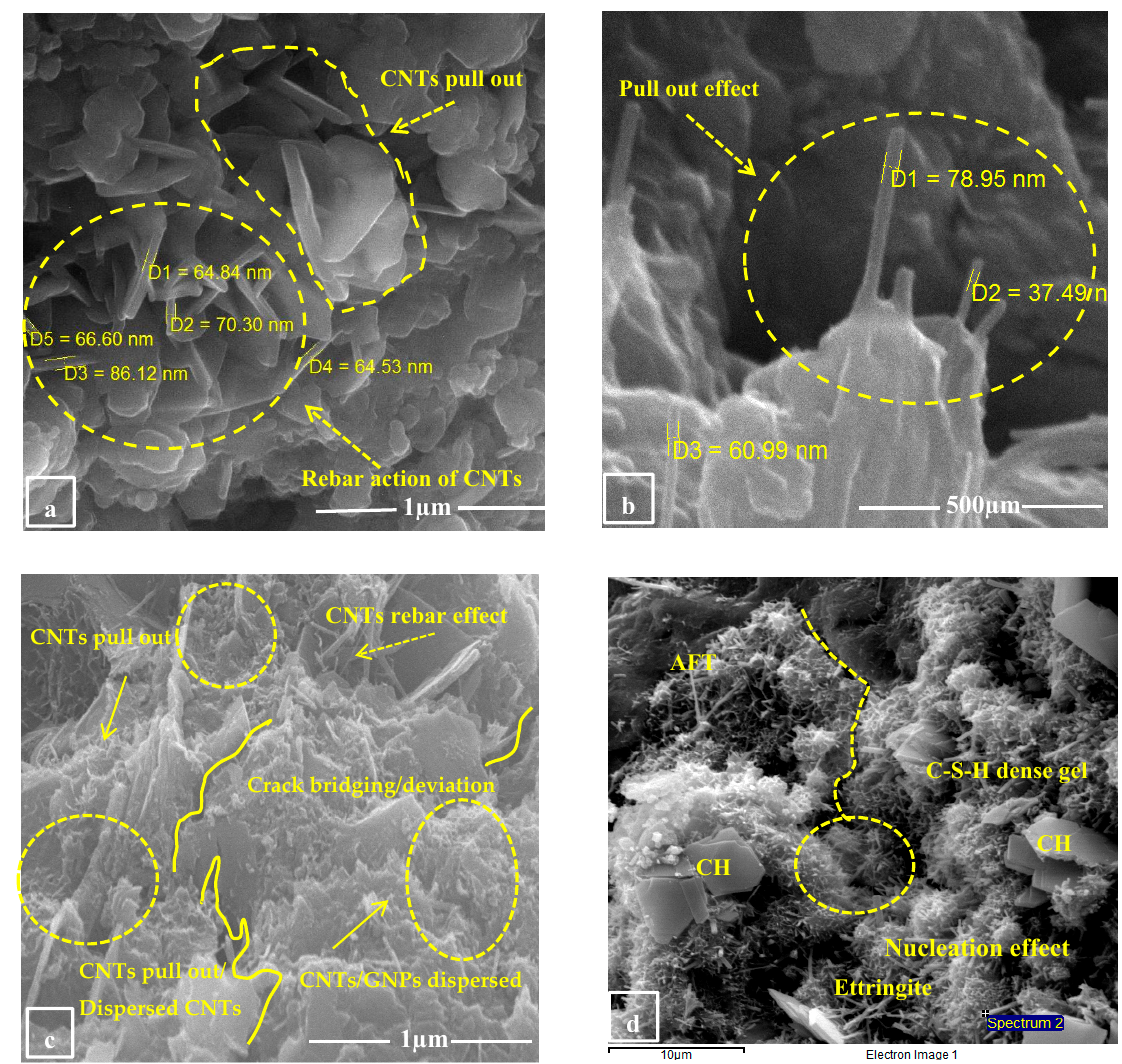
Figure 17. Strength of nanocomposite modified mortar. Figure 17 : Strength of nanocomposite modified mortar